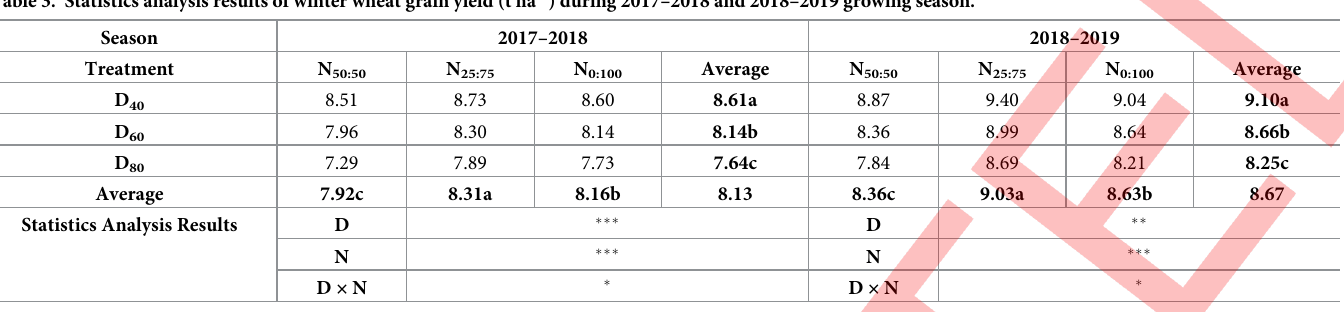
D = Drip irrigation lateral spacing, N = Nitrogen basal top dressing ratios. Average values indicating different letters are significantly different at P < 0.05. Significance level � (P < 0.05)